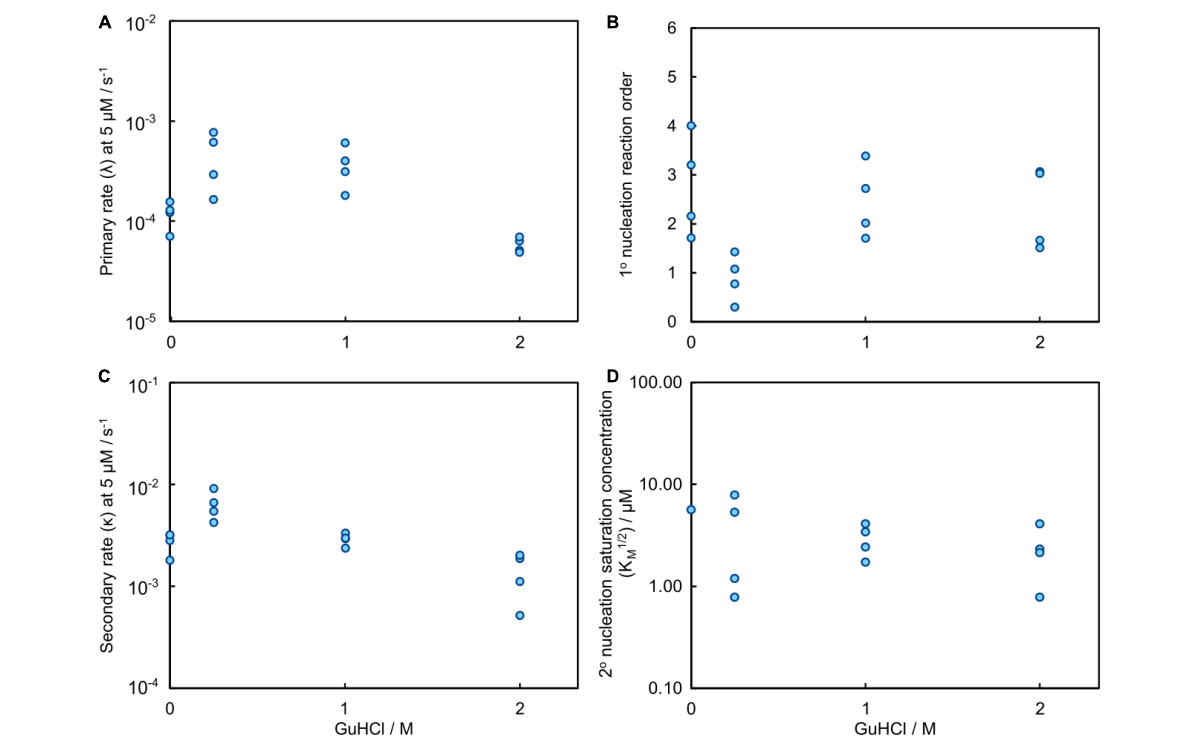
FIGURE8 Results of the global fitting for the aggregation process of A β 42 in GuHCl. (A) The rate at which fibrils are formed via the primary nucleation pathway, λ , evaluated at 5 µ M A β 42; it contains contributions from both elongation and primary nucleation (detailed definition see methods Equation 7). (B) The reaction order of primary nucleation shows a marked dip at 0.25 M GuHCl. The reaction orders are less well constrained than for the data obtained with urea because a smaller range of A β 42 concentrations was sampled in the presence of GuHCl. (C) The rate at which fibrils are formed via the secondary nucleation pathway, κ , evaluated at 5 µ M A β 42; it contains contributions from both elongation and secondary nucleation (detailed definition see methods Equation 6). (D) The monomer concentration at which secondary nucleation becomes half saturated. The saturation effect on the aggregation process decreases slightly in the presence of denaturant, however, the exact values are less well constrained than for the data obtained with urea because a smaller range of A β 42 concentrations was sampled in the presence of